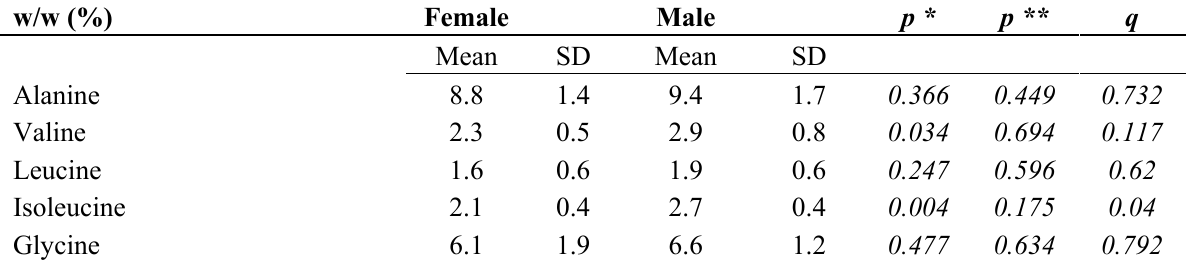
Table 6. Amino acids profile of PBMC in female and male subjects (Study